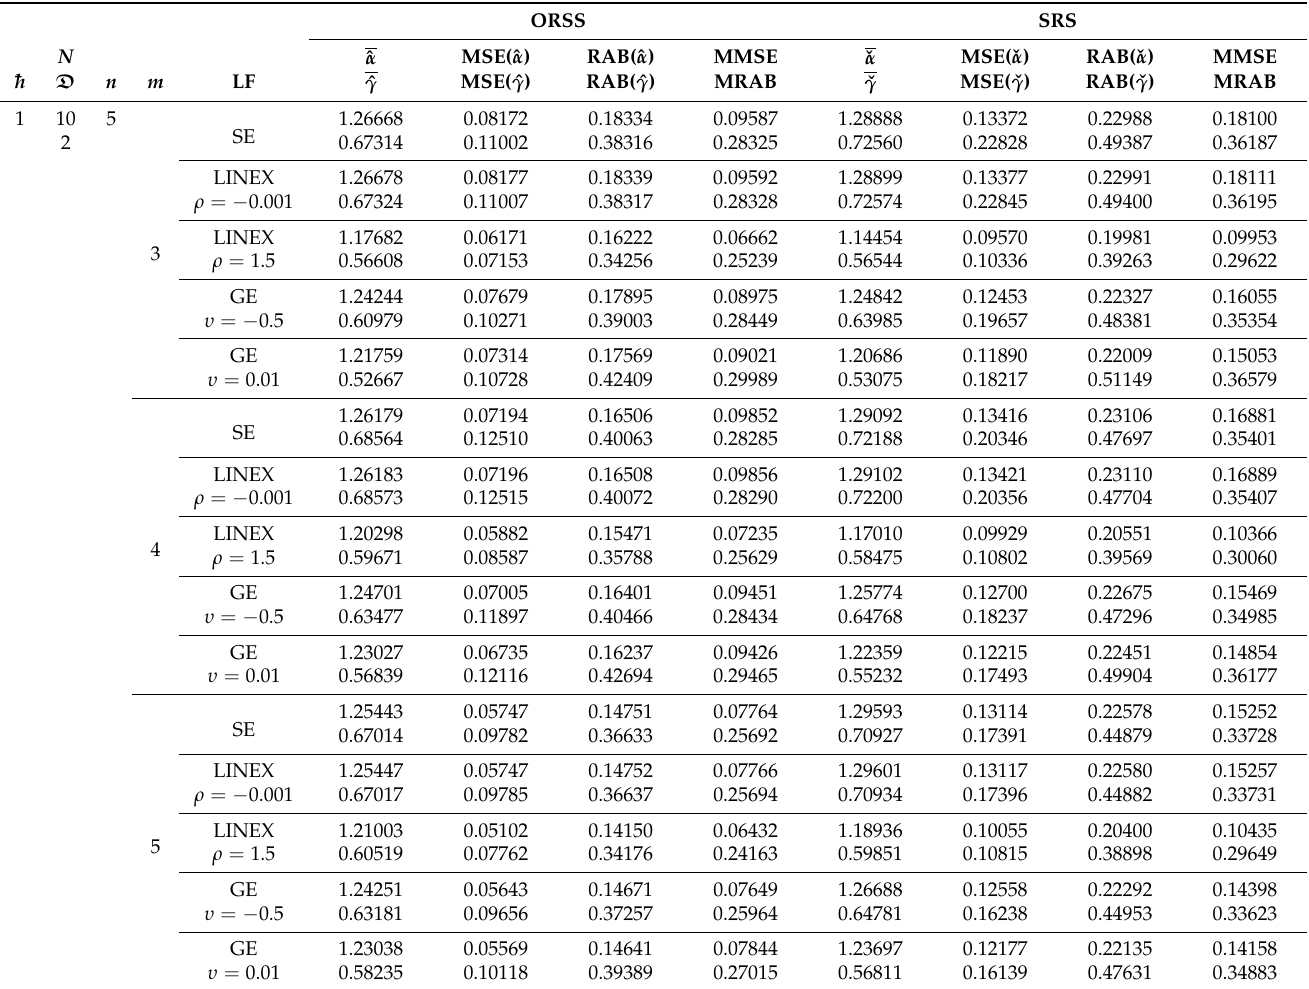
Table A2. BEs of α and γ with their MSEs, RABs, MMSE and MRAB based on 1000 SRSs and ORSSs of size N =